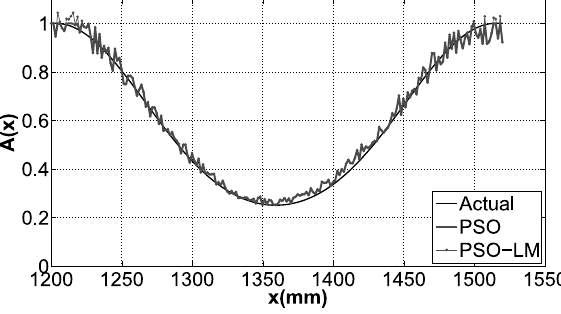
Fig. 30. Comparison between the actual and identi fi ed cross-section area pro fi